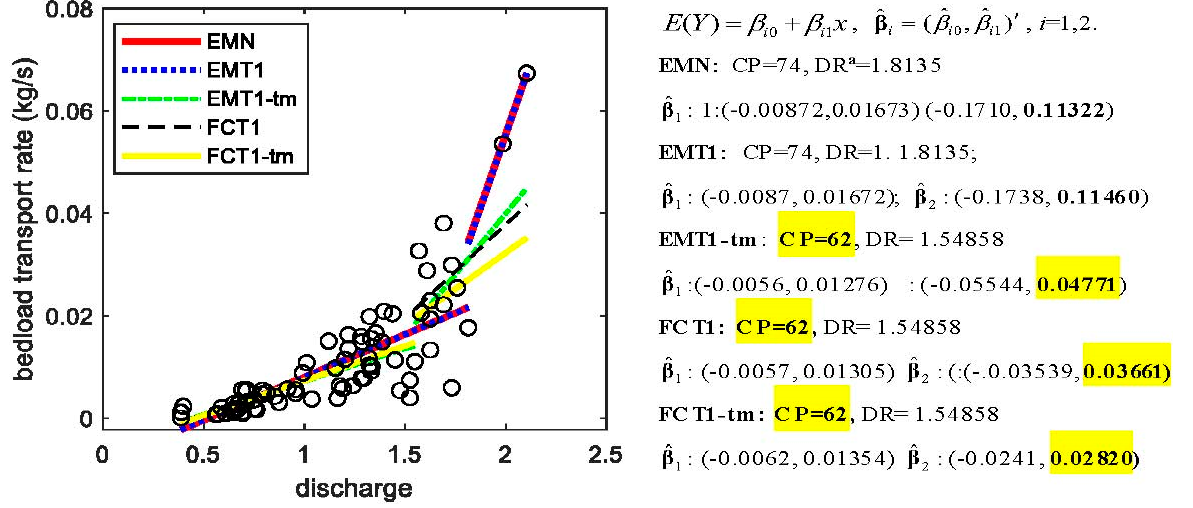
Figure 6. Fitting results of EMN, EMT1, EMT1-tm, FCT1 and FCT1-tm to bedload transport data. Table 4. Descriptive statistics of { R e